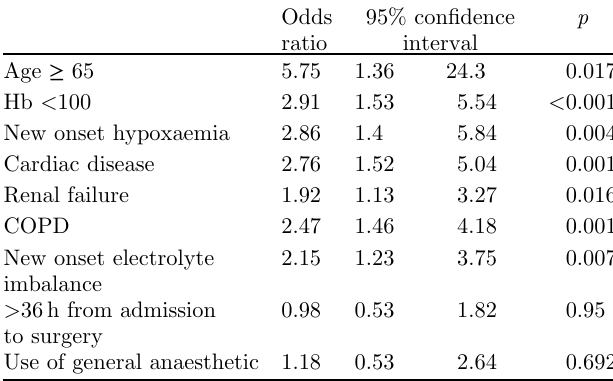
Table 5. Risk factors for postoperative